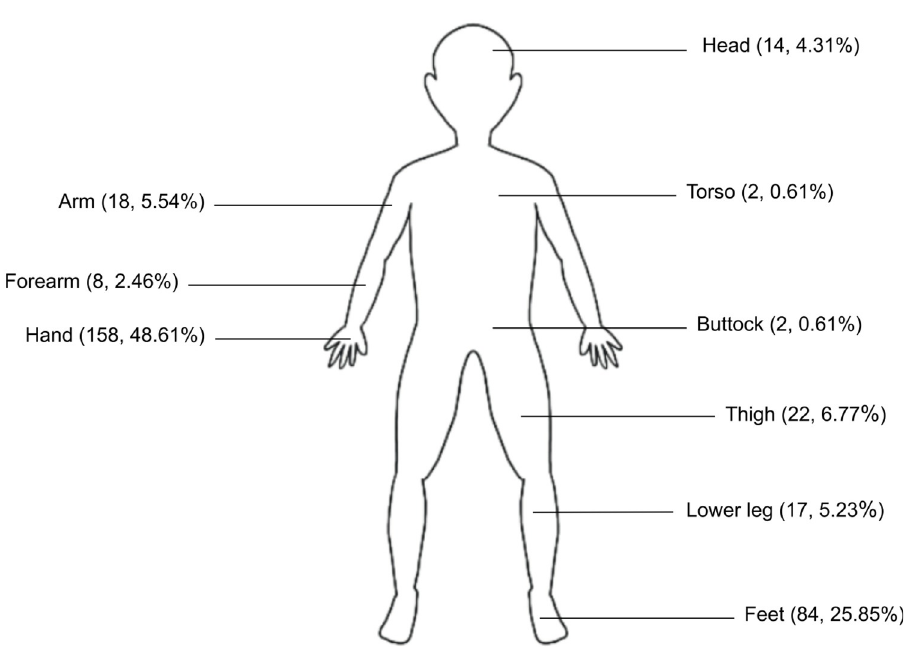
Fig 4. The frequency of anatomical region involved in bite injury from Tropidolaemus